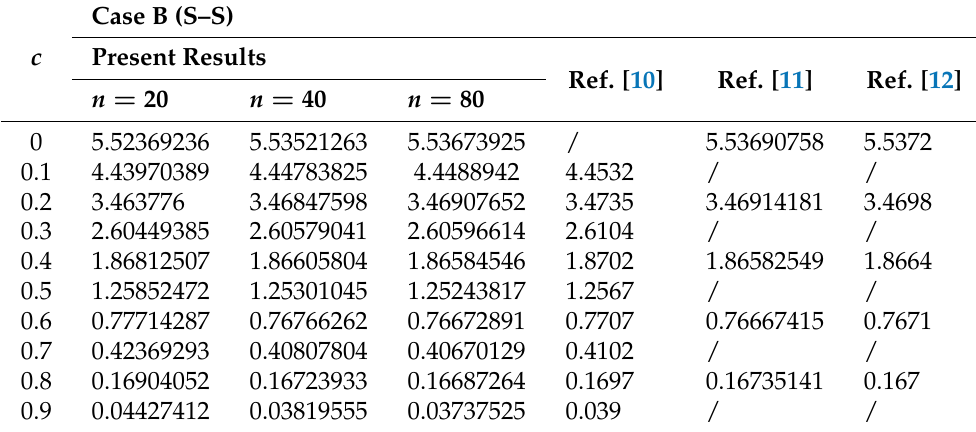
Table 5. Dimensionless critical load of an S–S axially FG Timoshenko beam with different taper coefficient ( m = 2).